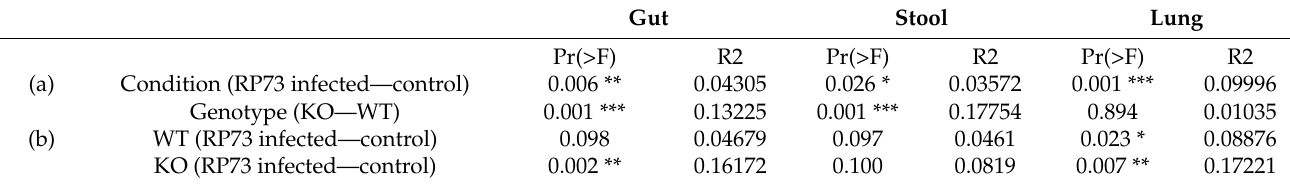
Figure 4. Principal component analysis (PCA) of mice microbiota. Pales shows the distribution of samples with respect to ( A ) infections; ( B ) WT mice and ( C ) KO mice in relation to districts. WT mice: empty beads n = 8 and RP73 infected n = 17; KO mice: empty beads n = 7 and RP73 infected n = 13. Table 2. Infection significantly impacts on both lung and gut microbiota. Impact of body site, genotype and infection on the overall dataset (a); or restricted to RP73 infected compared to controls (b). Results of Permanova on the microbiota composition evaluating the differences among conditions and genotypes. The probability (Pr > F after F statistic calculation) and R 2 values are reported for each body site (gut, stool, lung). WT mice: empty beads n = 8 and RP73 infected n = 17; KO mice: empty beads n = 7 and RP73 infected n = 13. Asterisks indicate significant values at p -values <0.05 *, 0.01 **, 0.001 ***.